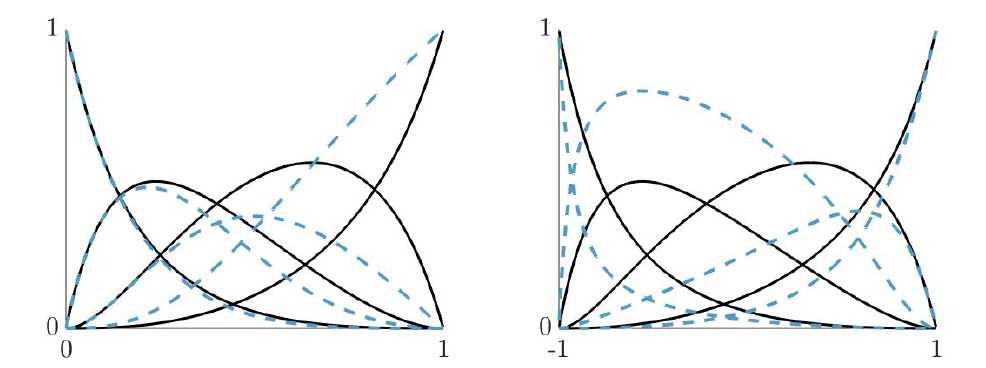
Figure 2. ( Left ): Rational basis (2) using f ( t ) = t , g ( t ) = 1 − t , t ∈ [ 0,1 ] . Weights w = [ 1,2,3,2 ] (black line) and weights w = [ 1,2,3,8 ] (blue dotted line). ( Right ): Rational basis (2) using f ( t ) = sin (( ∆ + t ) /2 ) , g ( t ) = sin (( ∆ − t ) /2 ) , t ∈ I = [ − ∆ , ∆ ] , 0 < ∆ < π /2. Weights w = [ 1,2,3,2 ] (black line) and weights w = [ 1,8,3,2 ] (blue dotted